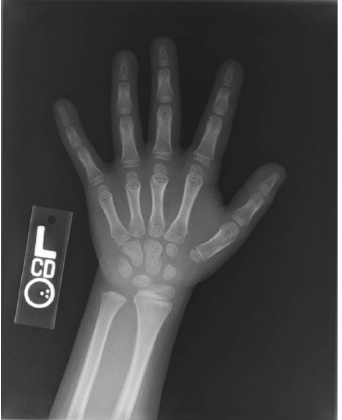
Figure 2: Shortened metacarpals (except the 2nd) of the left hand.